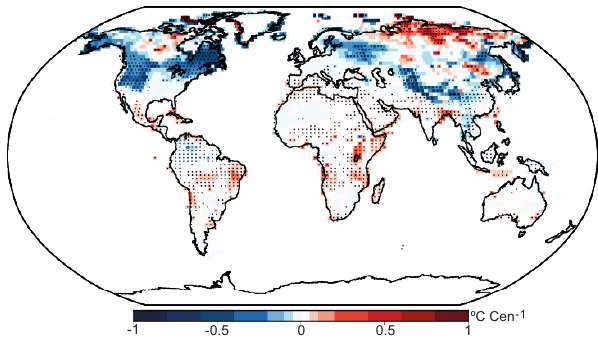
Figure 10. Spatial distribution of the linear trends for SAT minus GST in the OZ/AER-only ensemble. Trends are indicated in Cel- siuscentury − 1 . Dots indicate agreement in both of the ensemble